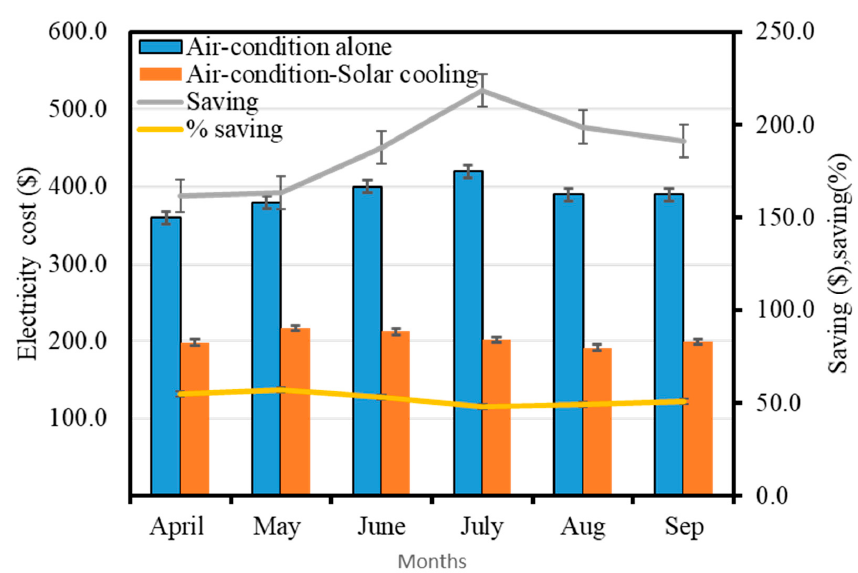
Figure 5. The monthly cost of space cooling using air-conditioner (AC) and combined AC-solar cooling system.